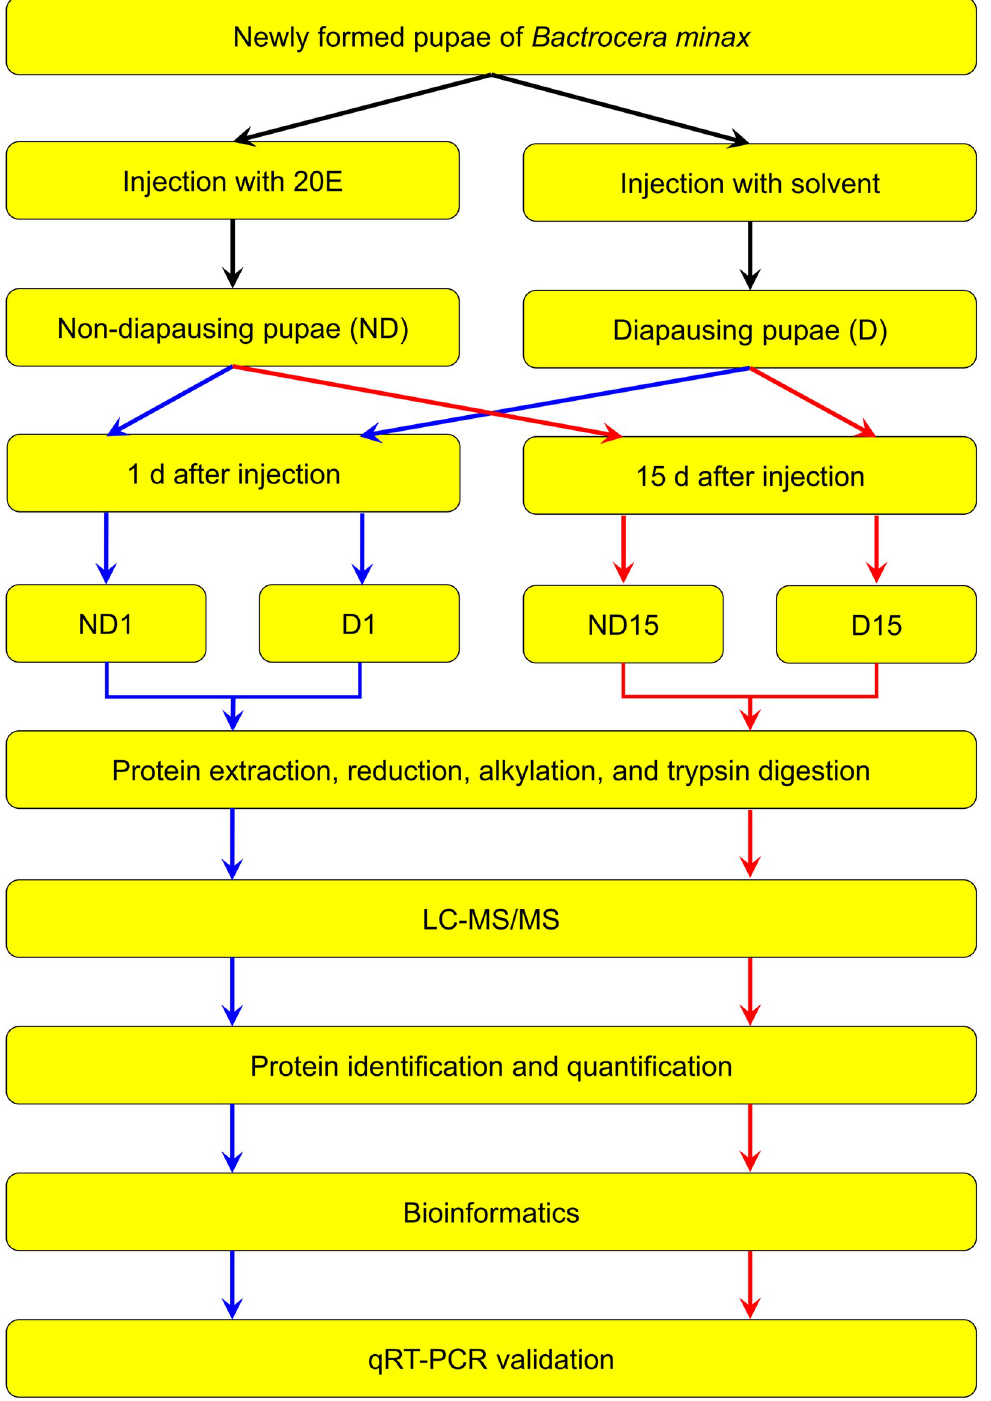
Fig 1. Diagram of workflow for comparative proteomics between non-diapause-(ND) and diapause-destined (D) pupae of Bactrocera minax . Blue and red arrows represent ND1 vs D1 and ND15 vs D15, respectively.